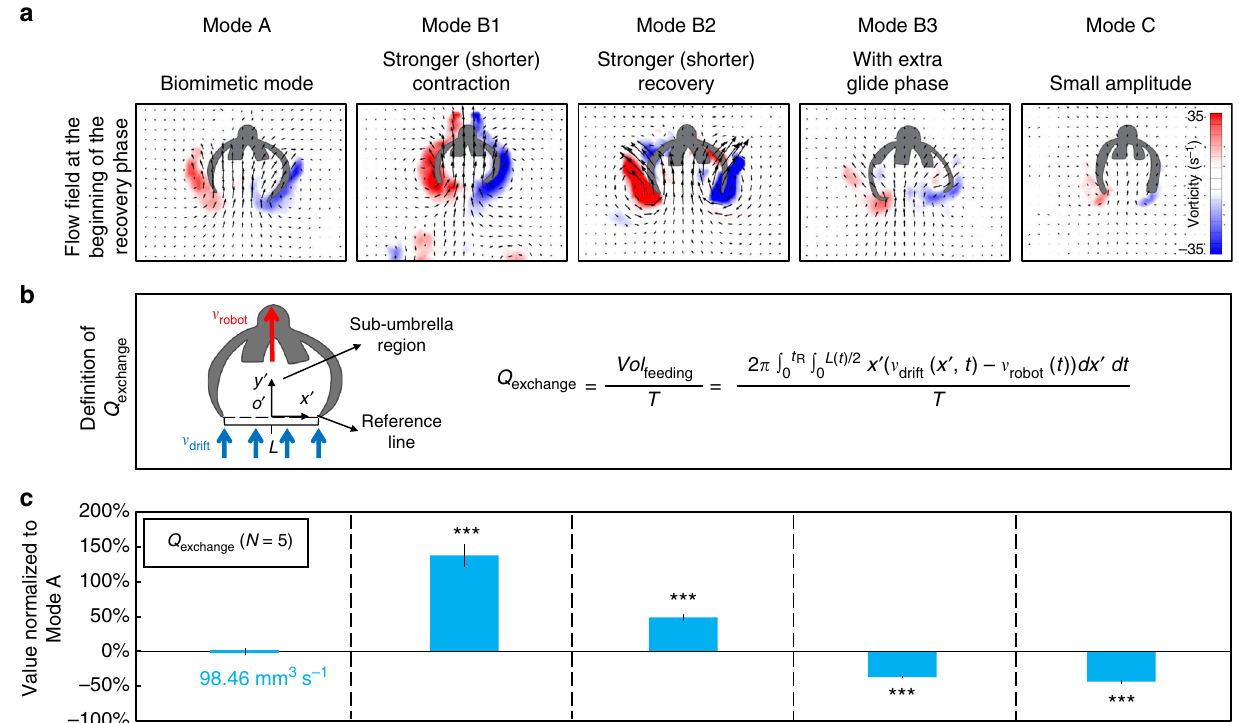
Fig. 3 The object collecting performance of the fi ve basic swimming modes. a The fl ow fi eld at the beginning of the recovery phase. The feeding fl ow is integrated from this time instant until the end of the recovery phase to estimate the volume fl ow sucked in during the recovery. The stronger stopping vortex suggests a stronger feeding fl ow. b The de fi nition of Q exchange . The equation estimates the volume of the feeding fl ow Vol feeding exchanged into the sub-umbrella region by applying the axisymmetric assumption and integrating the 2D velocity obtained from PIV along the reference line. c Q exchange of the fi ve basic swimming modes. A higher value indicates that the robot can collect objects faster. The error bars represent the standard error of the mean. N is the number of